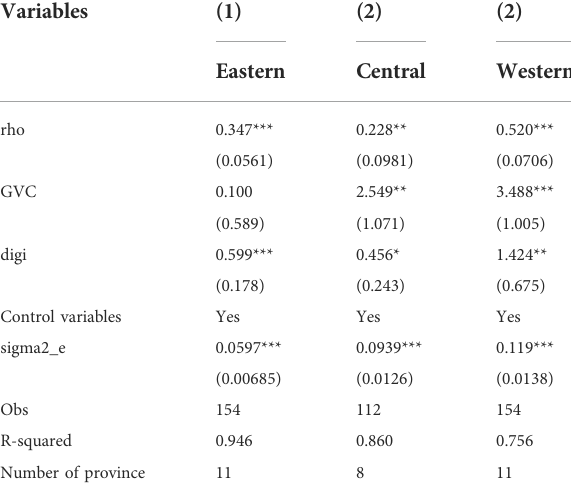
TABLE 8 Spatial autoregression analysis by